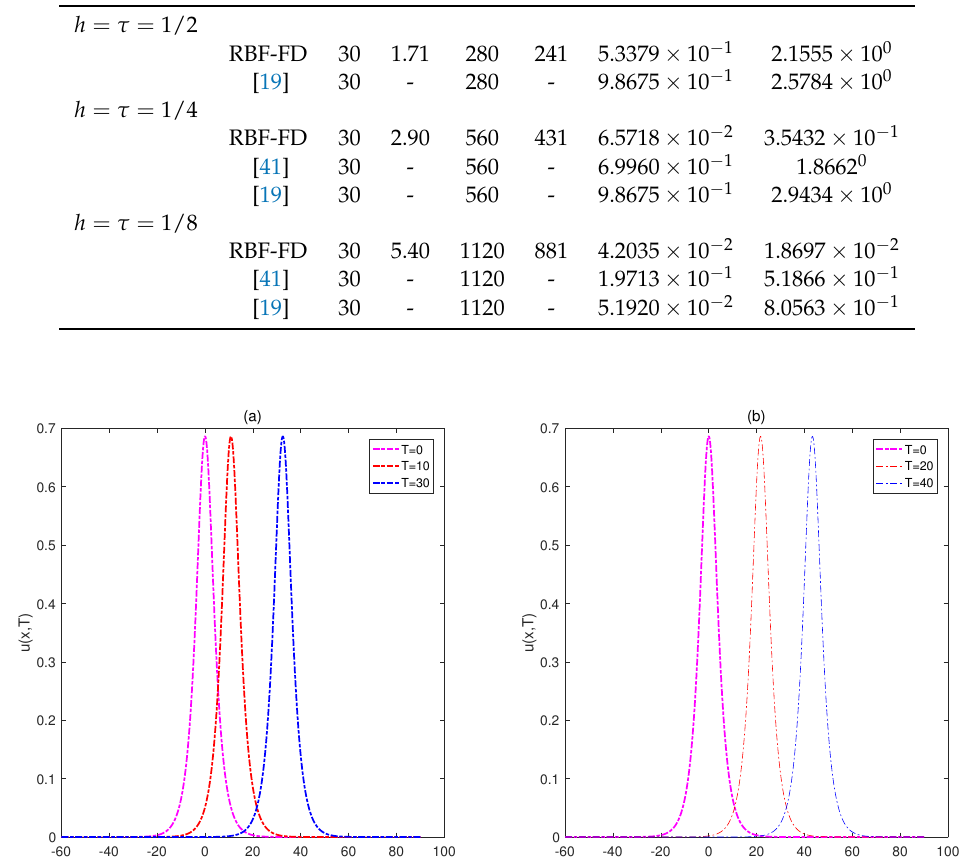
Figure 9. Motion of the single solitary wave with h = τ = 0.5 ( a ) and h = τ = 0.25 ( b ) over the interval x ∈ [ − 40,100 ] at final times T ∈ { 0,10,30 } ( a ) and T ∈ { 0,20,40 } ( b ) for Example 3.